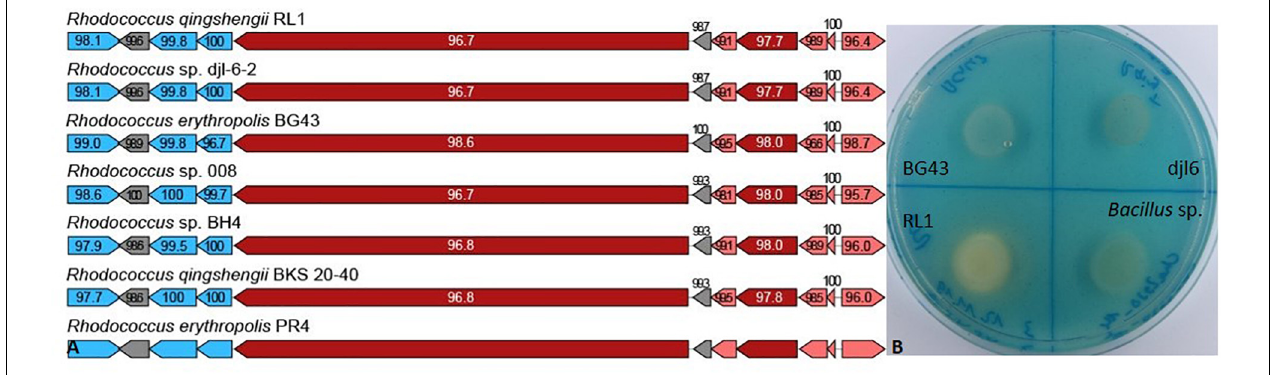
FIGURE 4 | Siderophore biosynthetic gene clusters and in vitro assay. (A) Heterobactin biosynthetic gene cluster based on antiSMASH results of Rhodococcus qingshengii RL1 compared to the reference genome of R. erythropolis PR4 and other Rhodococcus strains. Depicted as arrows are the core biosynthetic genes in dark red, additional biosynthetic genes in light red, transport-related genes in blue and additional genes in gray. The biosynthetic genes (dark and light red) are presented in order of their appearance from right to left encoding for isochorismate synthase, isochorismatase, 2,3-dihydro-2,3-dihydroxybenzoate dehydrogenase, 2,3-dihydroxybenzoate-AMP ligase, isochorismatase, and an amino acid adenylation domain-containing protein. Numbers indicate percentage of similarity to PR4. (B) In vitro assay for siderophore production of RL1, BG43, djl6 and Bacillus sp. detected with Chrome Azurol Blue overlay agar. Siderophore production is indicated by color change of the medium from blue to